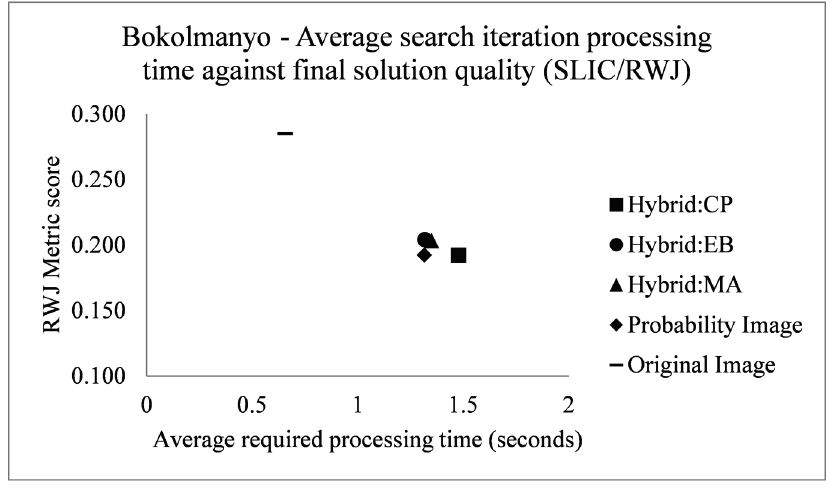
Figure 15. Search iteration execution time profiling for the Bokolmanyo problem instance.